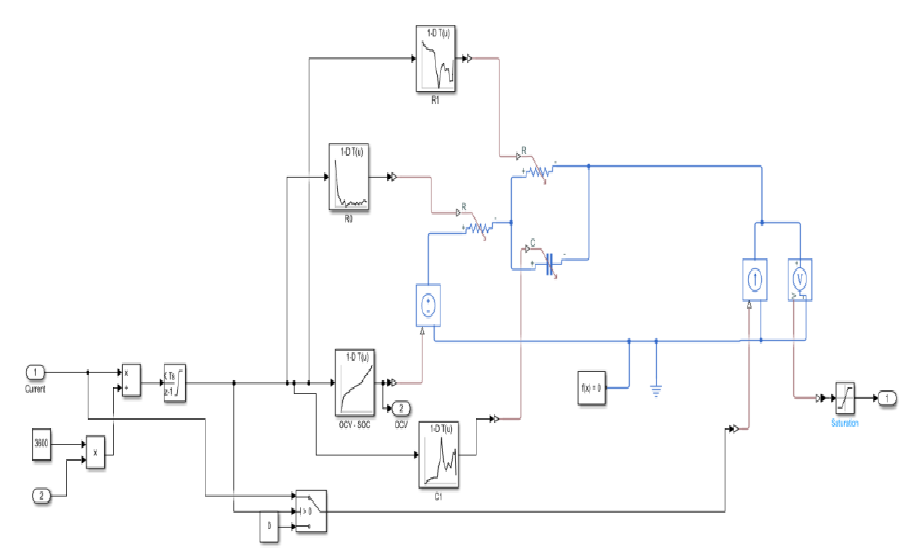
Figure 7. Cell Model developed using MATLAB/Simulink.